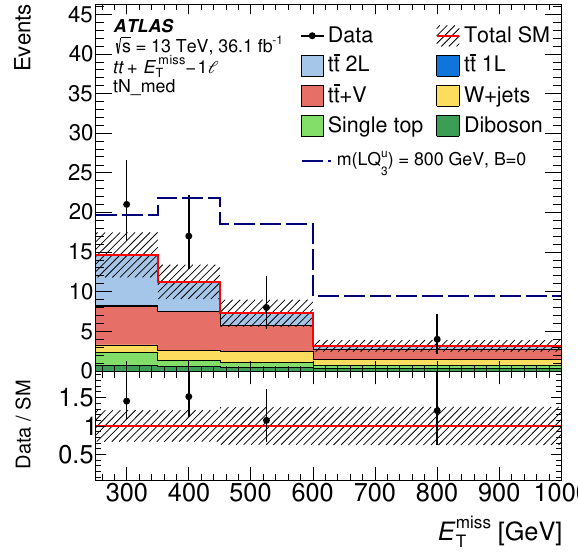
Figure 9 . Observed and expected E miss distributions are shown in the tN med signal region, as T is their ratio. The error band includes statistical and systematic uncertainties. The expected SM backgrounds are normalized to the values determined in the (cid:12)t. The expected number of signal events for an up-type LQ with m LQ = 800 GeV and B = 0 is added on top of the SM prediction. The last bin contains the over(cid:13)ow events.